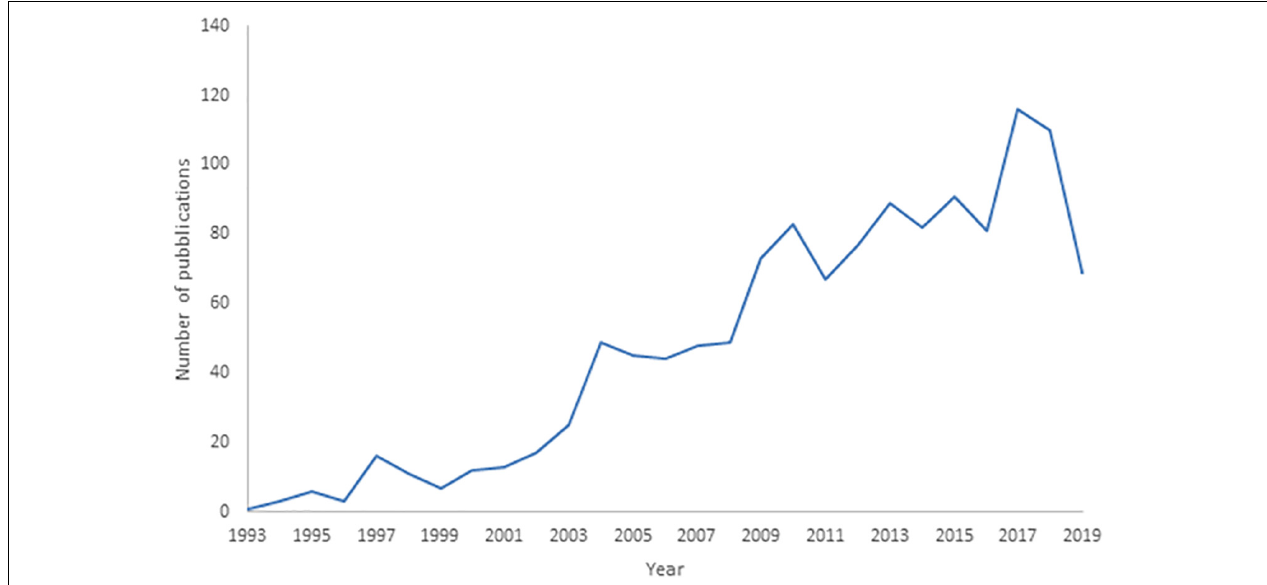
FIGURE 1 | Trend in deep-sea biodiversity as number of publications per year from 1993 to 2019 in Scopus. Note that publications of 2019 in the Scopus database are underestimated (being not yet all included).